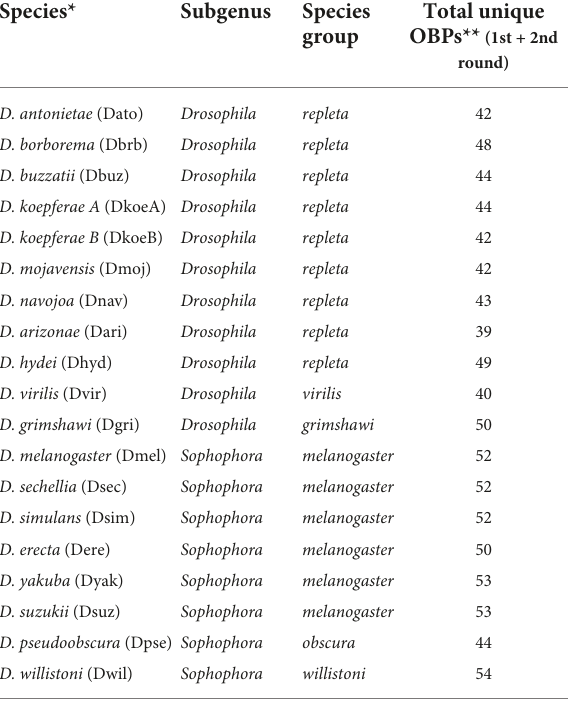
TABLE 1 Numbers of OBP genes identified in the Drosophila species included in this study.